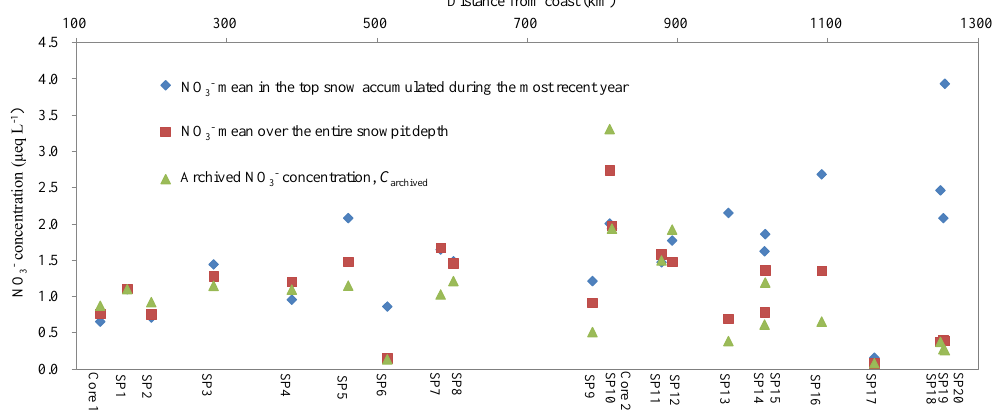
Figure 4. Mean concentrations of NO − for the entire snow pit depth (in square), the uppermost layer covering one-year snow accumulation 3 (in diamond) and the bottom layer covering a full annual cycle of deposition (archived NO −